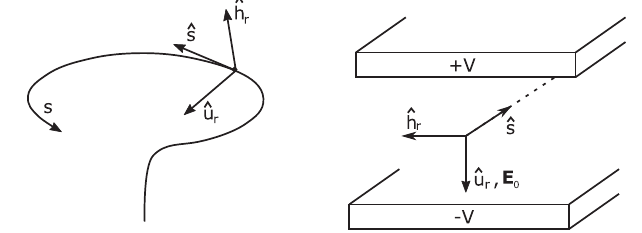
FIG. 3. Optical coordinate system around the central path